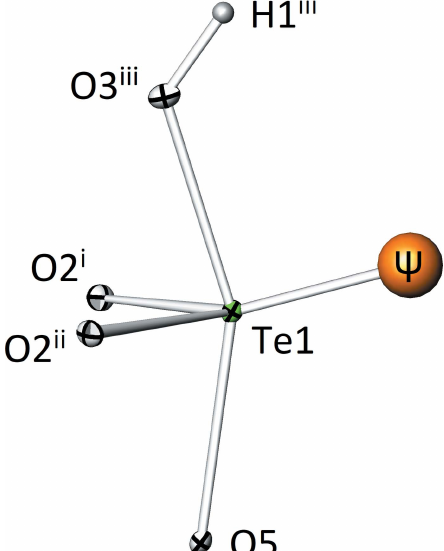
Figure 2 The bisphenoidal [TeO 3 OH] polyhedron in the crystal structure of Zn 2 (HTeO 3 )(AsO 4 ). Displacement ellipsoids are drawn at the 90% probability level. The 5 s 2 electron lone pair ( (cid:2) , orange) is drawn with an arbitrary radius of 0.2 A˚ . Symmetry codes refer to Table 1.